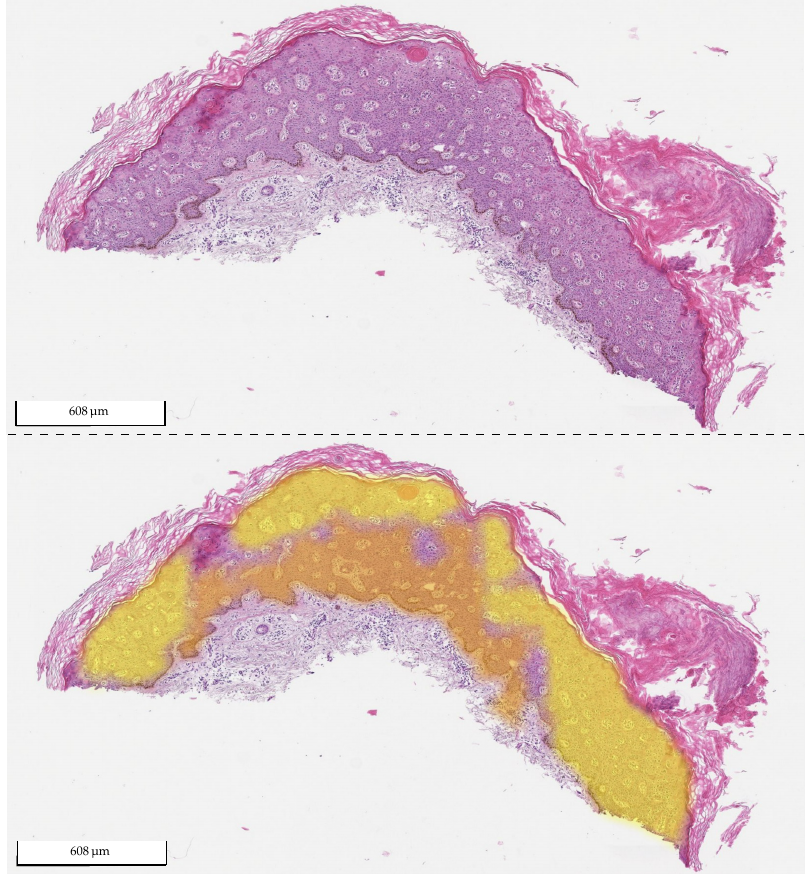
Figure 16. Exemplary tissue section of BD from Center 2 ( upper picture ) and the same tissue section with its corresponding two heat maps overlays ( lower picture ): yellow (BD) and orange (SK). The probability value between 0 and 1 was used to set the transparency. The relative area for the diagnosis of BD was ( r ): 77.04% > 20%. Therefore, it was classified as BD, which was correct.